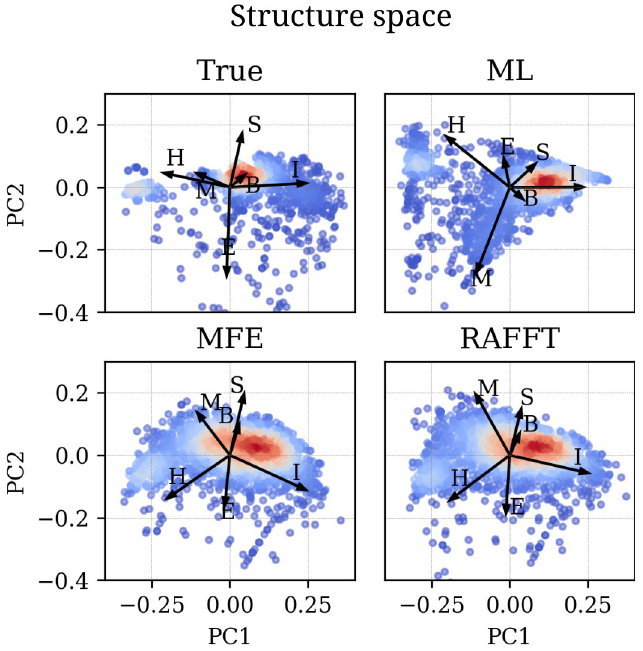
Fig 6. Structure space analysis. PCA for the predicted structures using RAFFT, RNAfold, MxFold2 compared to the known structures denoted “True”. The arrows represent the direction to secondary structure types (H = hairpin, I = E = exterior loop, I = interior loop, H = hairpin, B = bulge, S = stacks, M = multi-loop and R = root node).